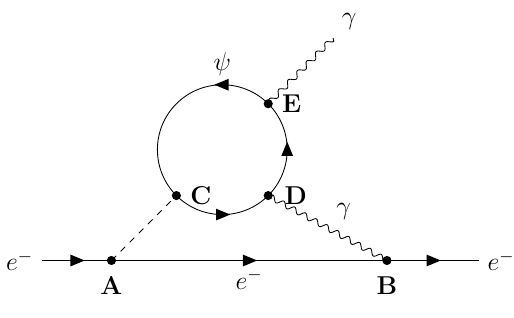
Figure 1 . Two-loop Barr-Zee diagram for the electron